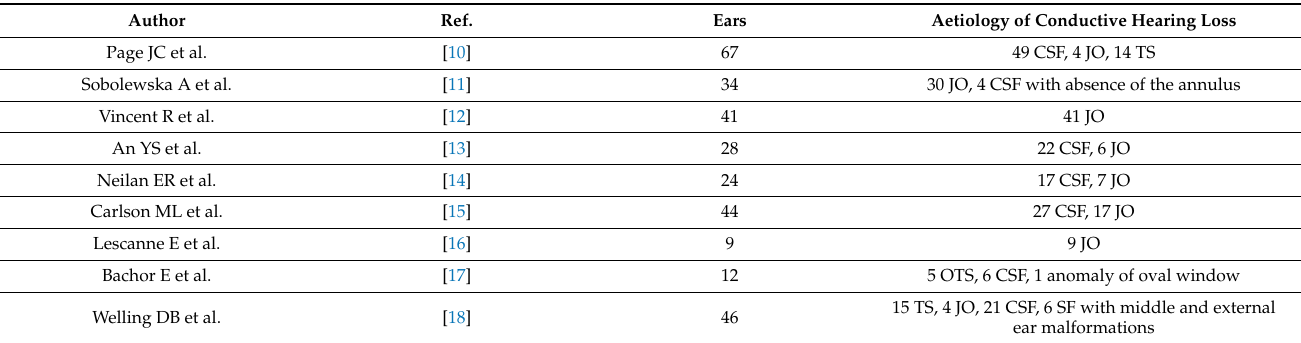
Table 1. Ears treated in total by each Author, with respective intraoperative features. (Figure legend: Ref. = reference; CSF = Congenital stapes fixation; JO = Juvenile Otosclerosis; TS = Tympanosclerosis; SF = Stapes fixation).